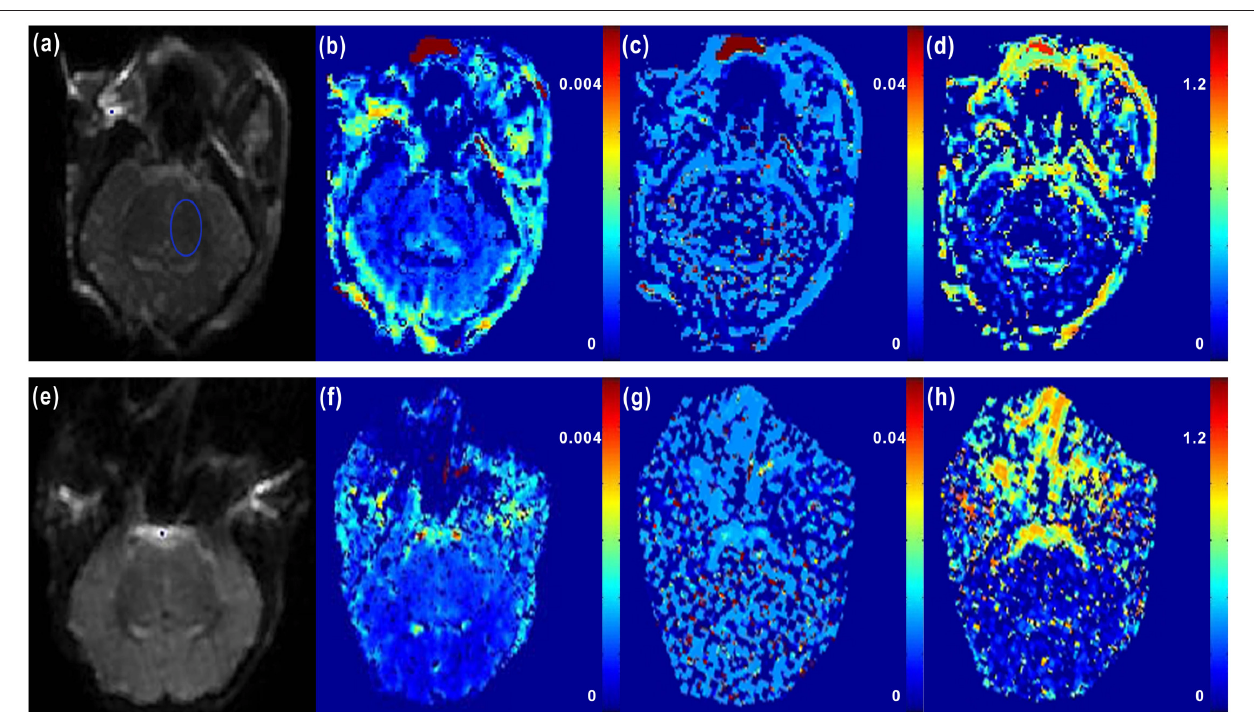
FIGURE 2 | Representative IVIM images of newborn piglets before and after HI. (a – d) showed the axial diffusion-weighted imaging (DWI) image ( b = 0 s/mm 2 ) of a normal newborn piglet (a) (where the blue ellipse highlights the region of interest (ROI) marked in the left basal ganglia region), and the corresponding D , D *, and f images obtained by IVIM post-processing software ( b – d ; D = 0.642 × 10 − 3 mm 2 /s, D * = 13.207 × 10 − 3 mm 2 /s, f = 12.753%). (e–h) showed the axial DWI image ( b = 0 s/mm 2 ) of a newborn piglet at 6 h after HI (e) , and the corresponding D , D *, and f images ( f – h ; D = 0.269 × 10 − 3 mm 2 /s, D * = 5.412 × 10 − 3 mm 2 /s, f = 7.197%). From the axial DWI images, we could see that at 6 h after HI, the signals of cerebral parenchyma were evidently enhanced, the cerebral cortex was obviously swollen and edematous, and the cortical sulci and gyrus became shallower; in the D and f images, weakened signals of cerebral parenchyma were observed after HI correspondingly, but the difference in the image of D * was not